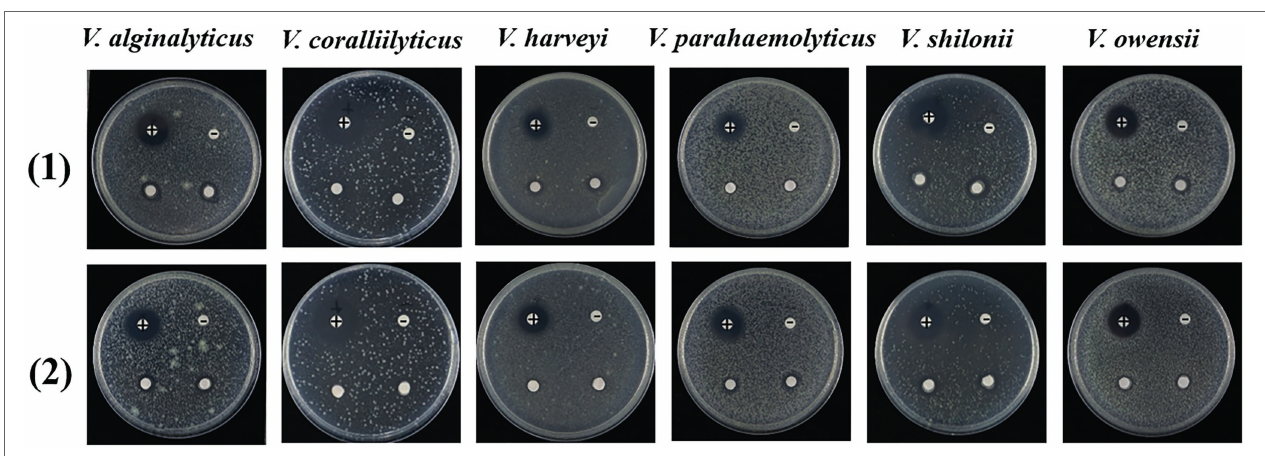
FIGURE 3 | Inhibitory activities of 1 and 2 against Vibrio . Each plate contains four pieces of paper disk, positive control marks as “+,” negative control marks as “–,” and the other two pieces of paper disk contains